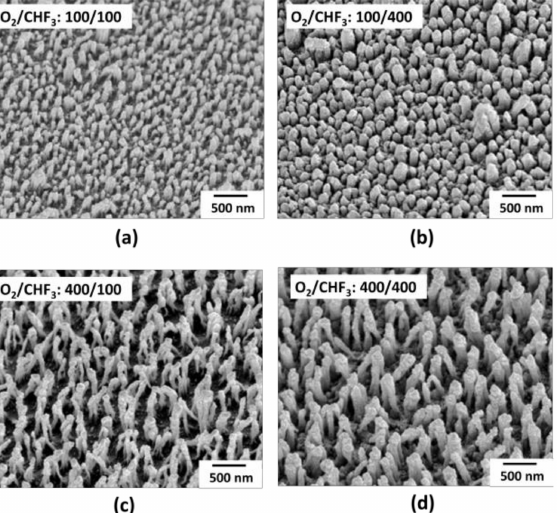
Figure 4. SEM image of MLA surface with different RIE process ( a ) O 2 100 s, CHF 3 100 s, ( b ) O 2 100 s, CHF 3 400 s, ( c ) O 2 400 s, CHF 3 100 s, and ( d ) O 2 400 s andCHF 3